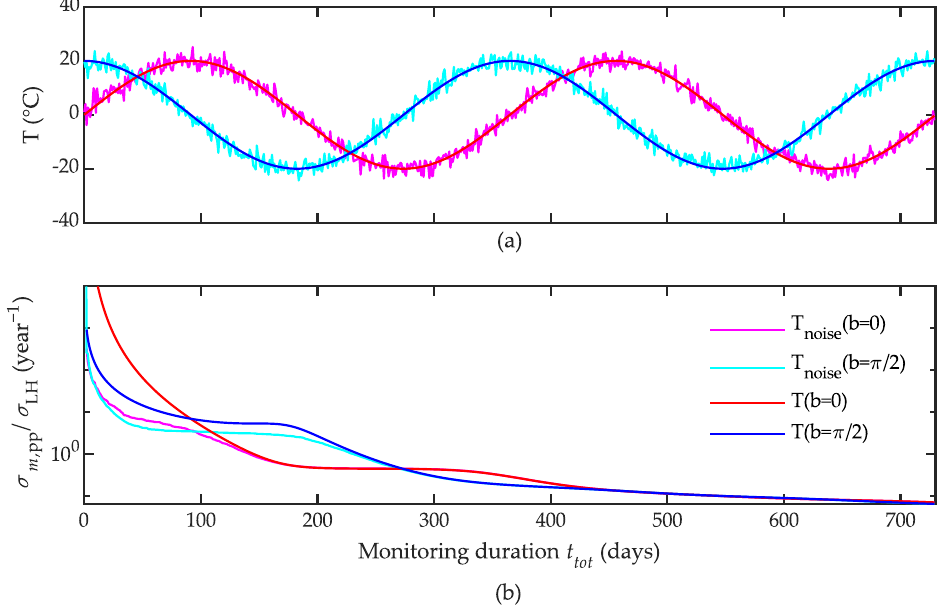
Figure 2. Impact of the day-by-day variation in temperature simulated as Gaussian noise n i ( σ noise ) on the pre-posterior uncertainty as the monitoring duration t tot increases from 1 to 730 days in the limit cases b = 0 and b = π /2. ( a ) Comparison between T noise and T ; ( b ) comparison between σ m ,pp ( T , t )/ σ LH and σ m ,pp ( T noise , t )/ σ LH . Temperatures with a = 20 ◦ C, c = 0 ◦ C, and σ noise = 2 ◦